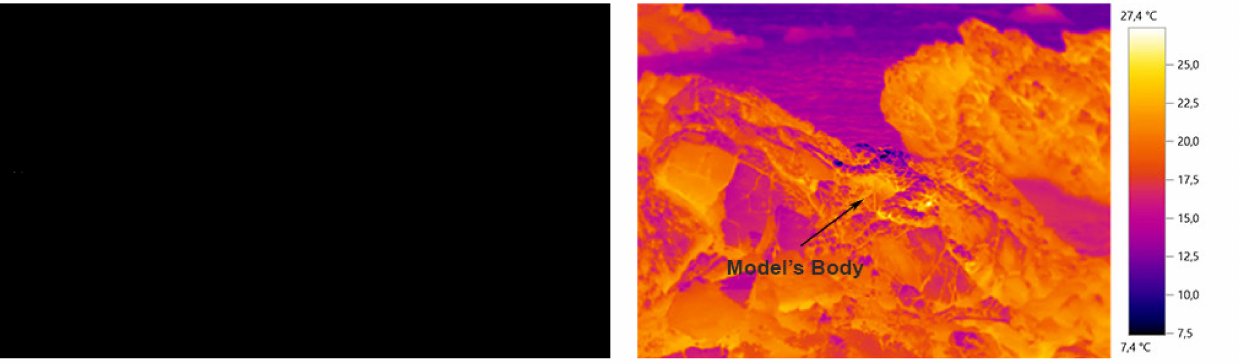
Figure 17. The conceptualized thermal camouflage prototype for the idealized nocturnal environment